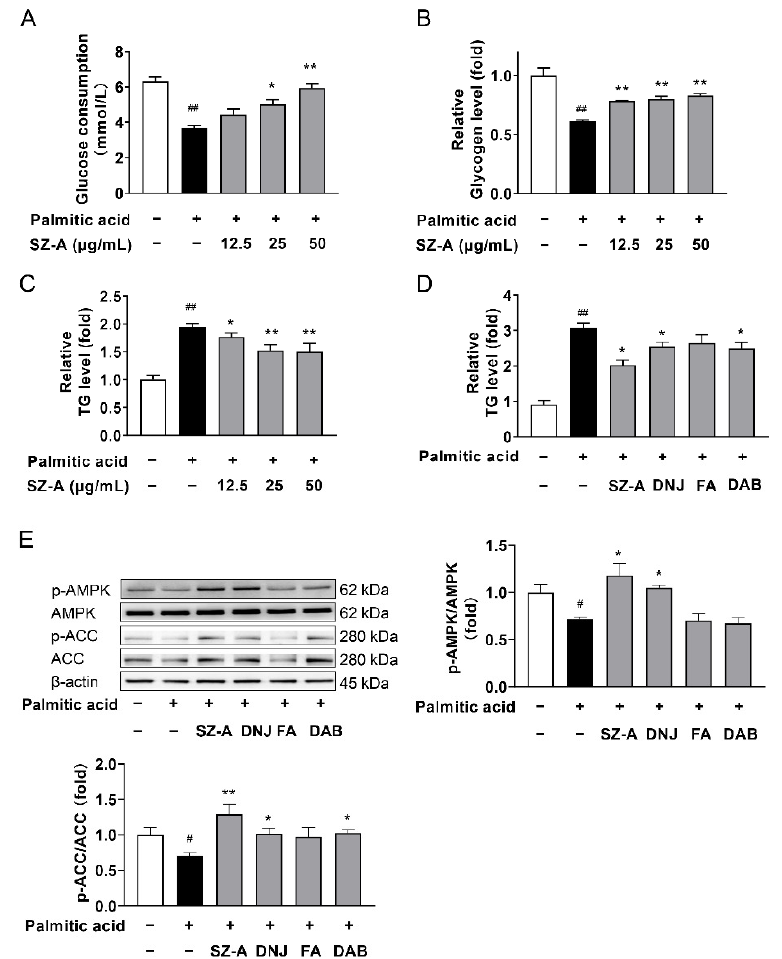
Figure 8. SZ-A regulates the AMPK signaling pathway in HepG2 cells. HepG2 cells were treated with PA (0.125 mmol/L) and/or SZ-A (12.5, 25, or 50 μg/mL), DNJ (40 μg/mL), FA (10 μg/mL), and DAB (10 μg/mL) for 24 h. Glucose consumption ( A ) and glycogen content ( B ) of each group was measured. ( C , D ) Levels of TGs in primary hepatocytes in the indicated groups. ( E ) Protein expres- sion levels of p-AMPK, AMPK, p-ACC, ACC, and β-actin in HepG2 cells were analyzed by Western blot. β-Actin was used as an internal reference. Data are shown as the mean ± SEM ( n = 4/group). # p < 0.05, ## p < 0.01 compared with cells treated with medium only, and * p < 0.05, ** p < 0.01 vs. cells treated with PA. TG, triglyceride; SZ-A, Ramulus Mori (Sangzhi) alkaloids; DNJ, 1-deoxynojirimy- cin; DAB, 1,4-dideoxy-1,4-imino-D-arabinitol; FA, fagomine; BSA, bovine serum albumin; PA, pal- mitic acid; AMPK, AMP-activated protein kinase; ACC, acetyl-CoA carboxylase; p-AMPK, phos- pho-AMP-activated protein kinase; p-ACC, phospho-acetyl-CoA carboxylase.